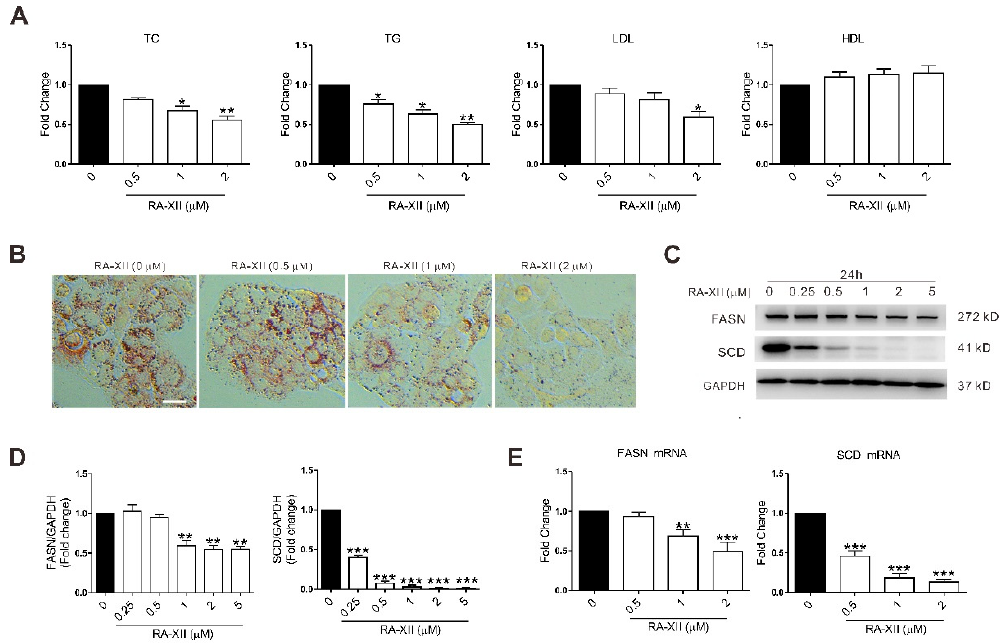
Figure 2. RA-XII inhibits the lipid synthesis in HepG2 cells. ( A ) Concentrations of total cholesterol (TC), triglycerides (TG), low-density lipoprotein (LDL), and high-density lipoprotein (HDL). ( B ) Lipid droplet test by Oil Red O staining. Scale bar: 50 µ m. ( C ) Protein expression of the (fatty acid synthase) FASN and stearoyl CoA desaturase (SCD). ( D ) Statistical graphs of protein expression. ( E ) Gene expression of FASN and SCD. Cells were treated with different concentrations of RA-XII for 24 h. Results are means ± SEM of three independent experiments. * p < 0.05, ** p < 0.01, *** p < 0.001, compared with 0 μ M.